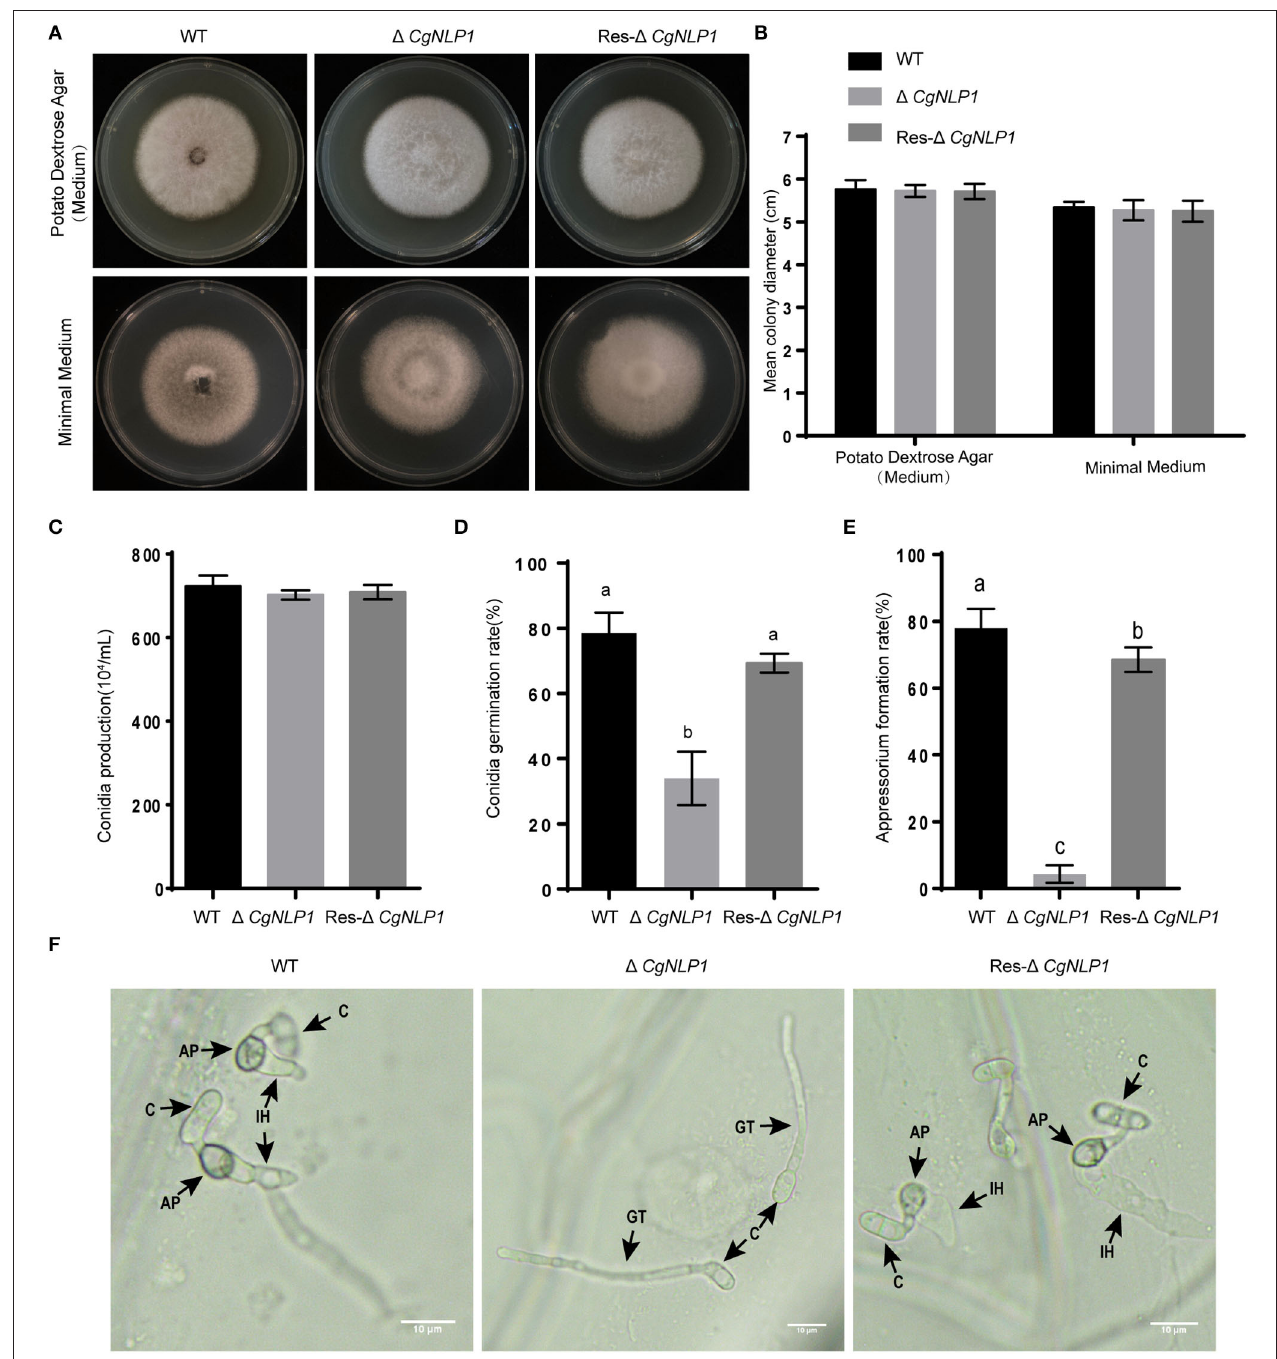
FIGURE 3 | The radial growth, conidiation, and appressorium formation assays of CgNLP1 deletion mutant and CgNLP1 complementation mutant. (A) Hyphal blocks from Cg-WT, 1 CgNLP1, and Res- 1 CgNLP1 were inoculated on potato dextrose agar (PDA) medium and minimal medium for 6 days at 28 ◦ C, and this experiment was repeated three times. (B) Colony diameters at 6 days of post-inoculation. (C) The number of conidia developed by Cg-WT, 1 CgNLP1, and Res- 1 CgNLP1. (D) Conidial germination rates of Cg-WT, 1 CgNLP1, and Res- 1 CgNLP1 at 4h time intervals. (E) Appressorium formation rates of Cg-WT, 1 CgNLP1, and Res- 1 CgNLP1 at 12h time intervals. Error bars indicate SD, and columns with different letters indicate a significant difference ( P < 0.05). (F) Equal volumes (30 µ l) of conidial suspensions (2.5 × 10 5 conidia/ml) from Cg-WT, 1 CgNLP1, and Res- 1 CgNLP1 were inoculated on the onion epidermal cells. C, AP, IH, and GT indicate the conidia, appressorium, infection hyphae, and germ tube, separately. This experiment was repeated three times. Bars = 10 µ m.